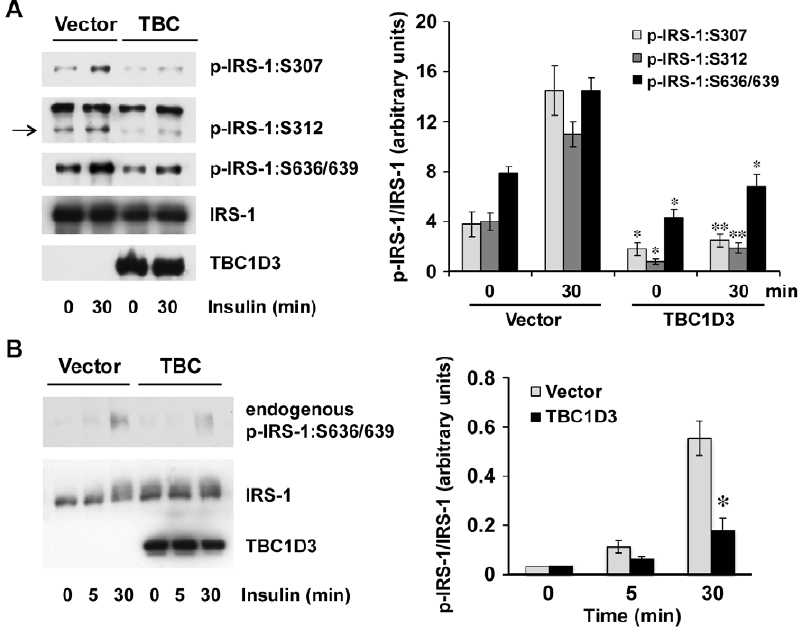
Figure 2. TBC1D3 selectively decreases IRS-1 Serine phosphorylation. (A) Empty vector or myc-TBC1D3 was co-transfected with pCIS2-IRS-1 in Hek293 cells. Cells were stimulated with insulin (10 nM) for 30 min. Phosphorylation and protein levels of IRS-1 were analyzed by Western blotting. ( Right panel ) Quantification data of IRS-1 phosphorylation normalized to IRS-1 protein levels (* p , 0.05, ** p , 0.01). (B) Hek293 cells were transfected with myc-TBC1D3 or empty vector, serum-starved and stimulated with insulin (10 nM) for 5 or 30 min. Phosphorylation of endogenous IRS-1:S636/ 639 was analyzed by Western blotting. ( Right panel ) Quantification data of endogenous IRS-1 phosphorylation normalized to IRS-1 protein levels (* p , 0.05). The data are presented as means 6 SD of three independent experiments.